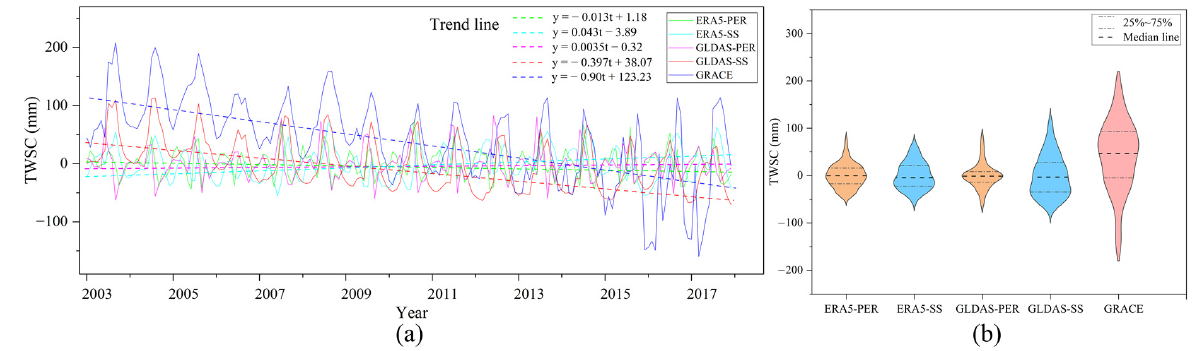
Figure 2. Comparison of the variation trend ( a ) and amplitude ( b ) of TWSC based on ERA5 and GLDAS with the results derived from GRACE from 2003 to 2017. ERA5-PER represents TWSC estimated by the PER method based on ERA5; ERA5-SS represents TWSC estimated by the SS method based on ERA5; GLDAS-PER represents TWSC estimated by the PER method based on GLDAS; GLDAS-SS represents TWSC estimated by the SS method based on GLDAS; GRACE represents the TWSC derived from GRACE. The dashed line in Figure 2a represents the corresponding trend line.